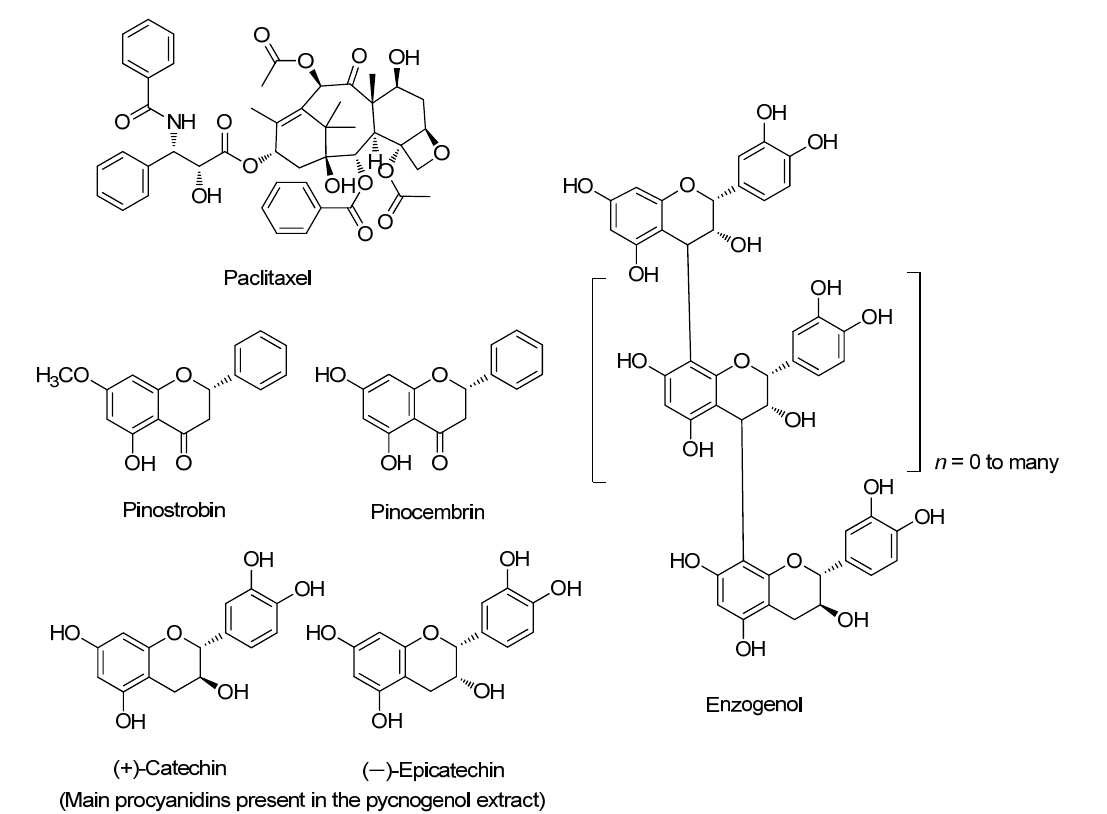
Figure 1. Chemical structures of the commercially available products displayed in Table 1. Table 1. Gymnosperm-derived commercially available products with therapeutic